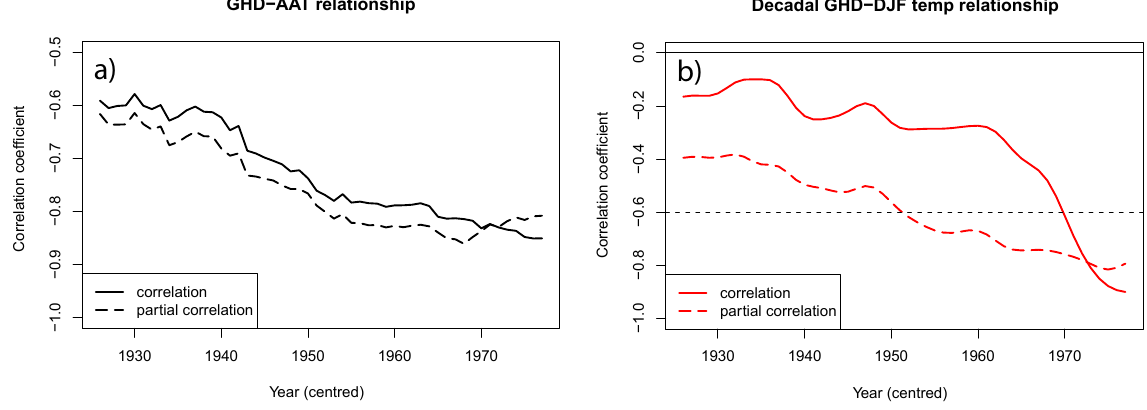
Fig. 10. Comparison of the development of the full correlation (solid lines) and the partial correlation (dashed lines). (a) GHD-AAT relationship (b) decadal GHD-DJF temperature relationship. The horizontal dashed line shows the p =0.05 significance level. The length of the time window is 50 years. In the partial correlation, we eliminate the influence of the decadal DJF temperature in (a) and the decadal AAT in (b) . See text for the